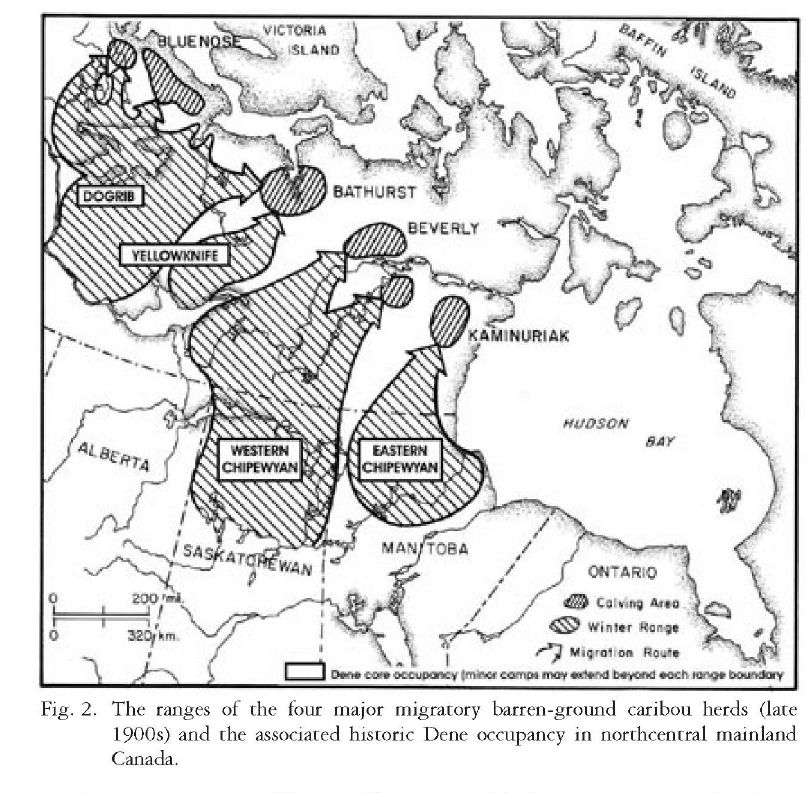
Fig. 2. The ranges of the four major migratory barren-ground caribou herds (late 1900s) and the associated historic Dene occupancy in northcentral mainland